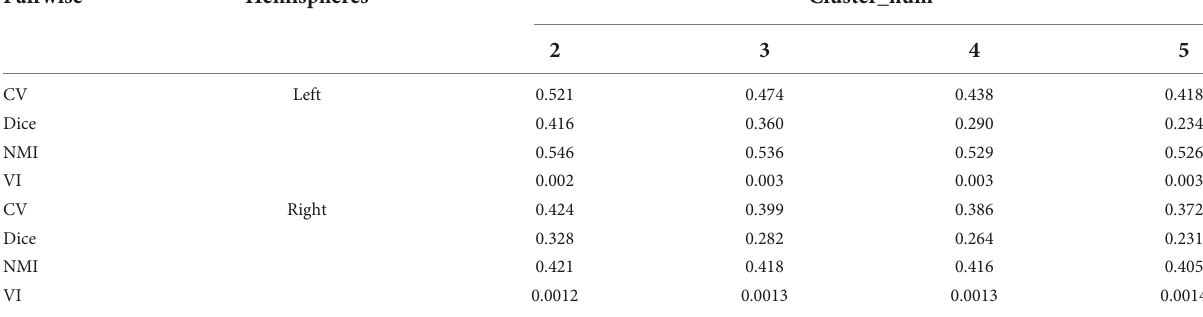
TABLE 1 Evaluation indexes of PE segmentation of the left and right brains of macaques. Pairwise Hemispheres